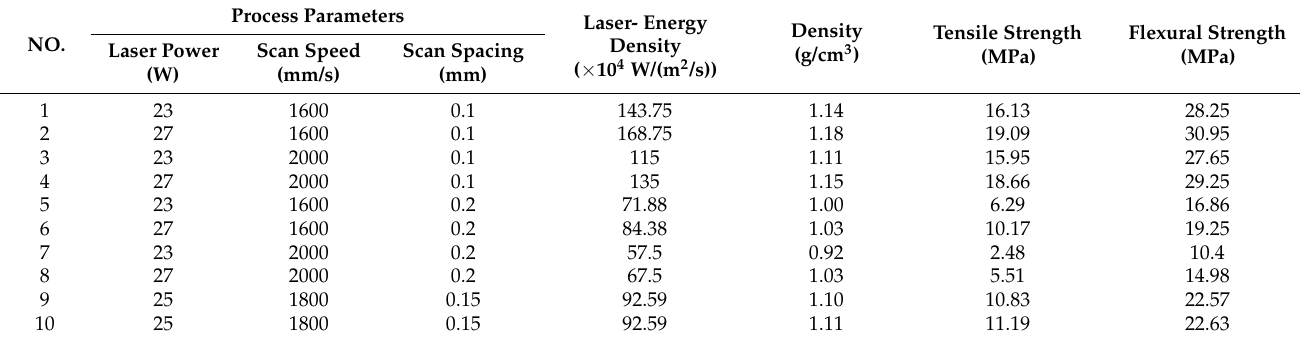
Table 1. Full factorial design scheme and mechanical properties of laser-sintered 10%-CPLA parts.